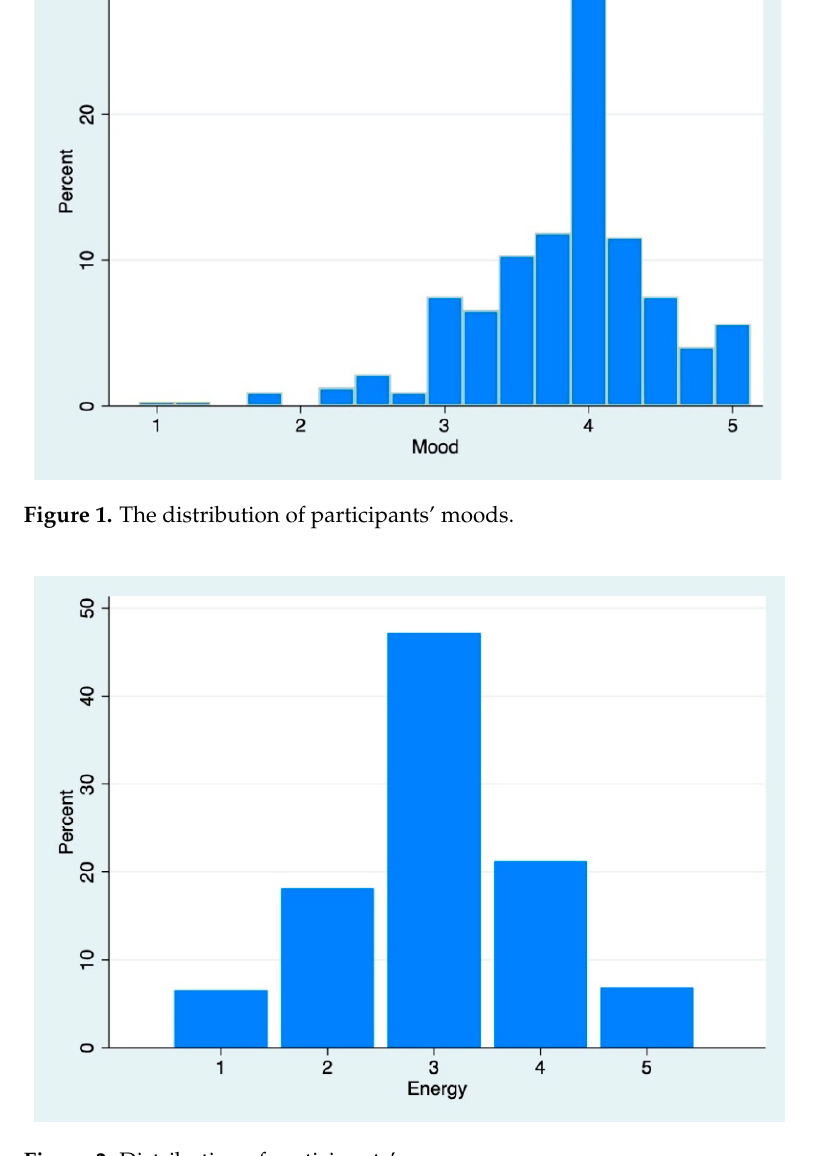
Table 1. OLS estimation showed that Immersion and peak Immersion have positive effects on Mood. When predicting high and low Mood using a logit estimation, only peak Immersion was significant. Sick and Male are controls. Standard errors are in parenthesis and * = p < 0.05, ** = p < 0.01, *** = p < 0.001.